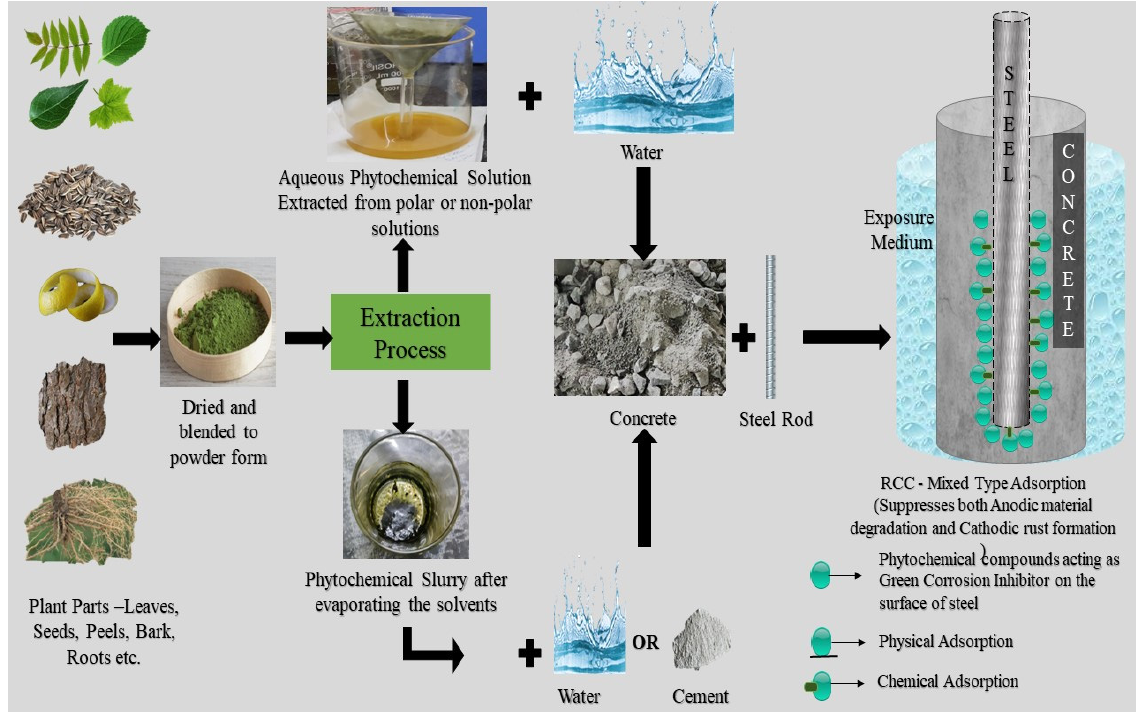
Figure 10. Concise overview of green corrosion inhibitors in RCC.